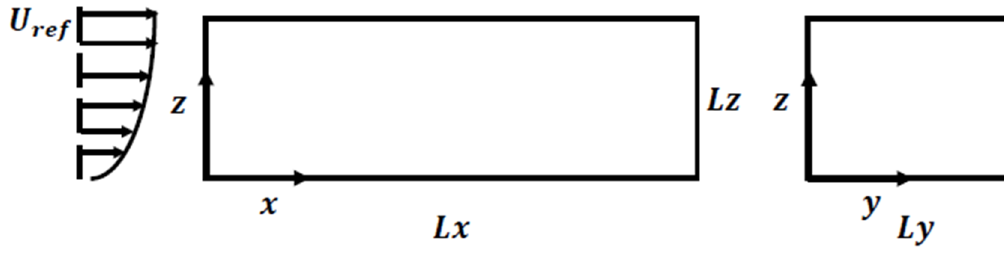
Figure 1. Schematic diagram of the computational domain.